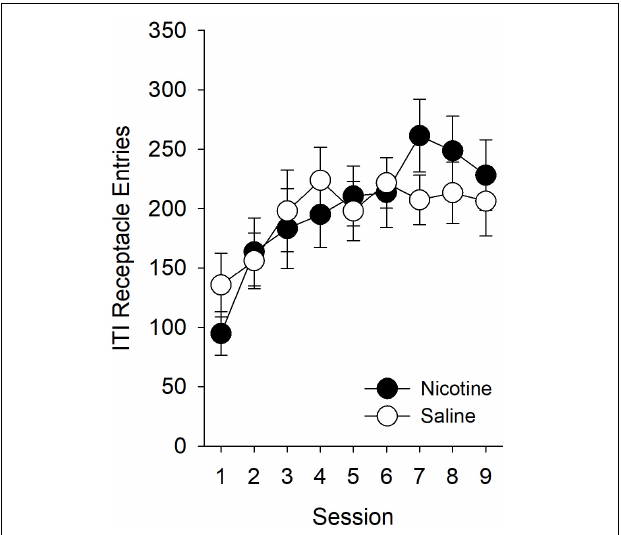
FIGURE 5 | In experiment 2, nicotine had no effect on the number of goal location entries during the ITI. As in experiment 1, we sought to determine whether nicotine had any non-specific effect on behavior directed toward the goal location by evaluating the effect of nicotine on receptacle entries during the ITI. In this experiment, nicotine did not have any effect on the number of receptacle entries during the ITI. Therefore, we did not compute an elevation score for experiment 2 and report the raw values for the number of goal-tracking responses in Figure 6A